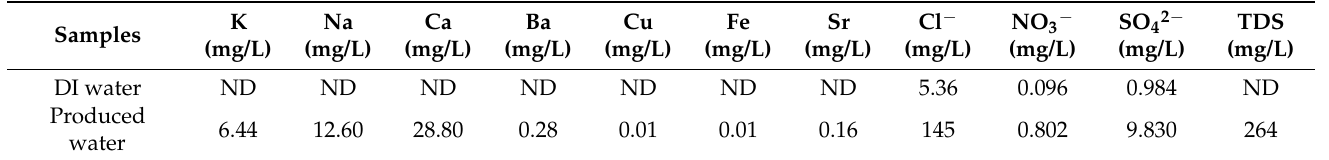
Table 2. Metal elements, anions, and TDS of DI water and produced water.